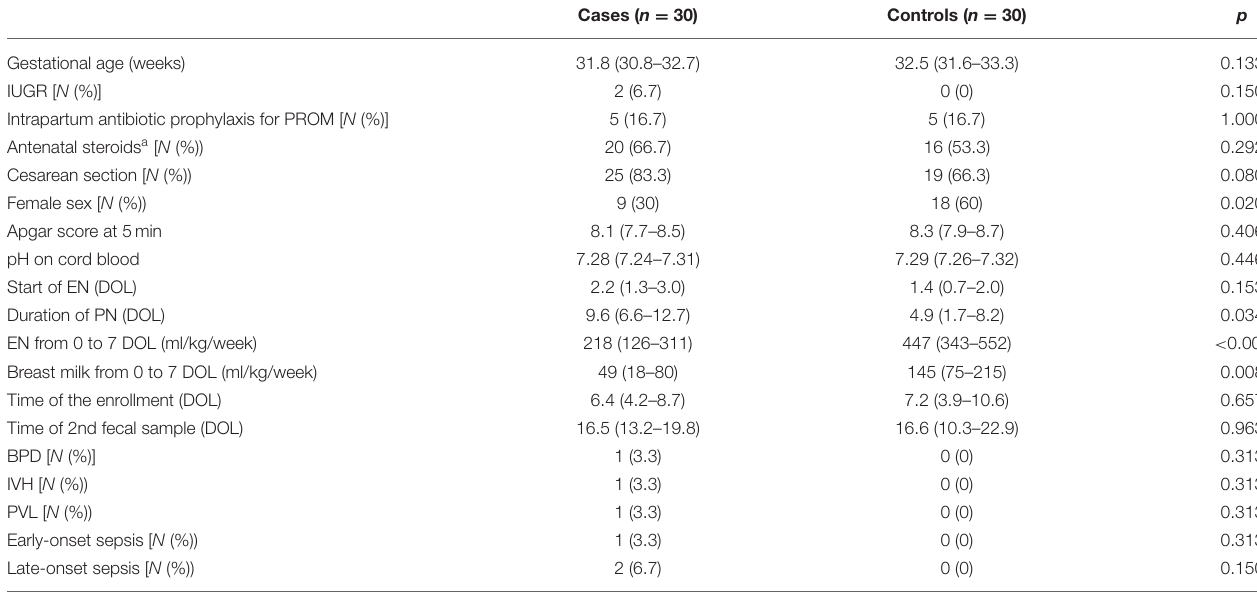
TABLE 1 | Clinical characteristics of the study population.